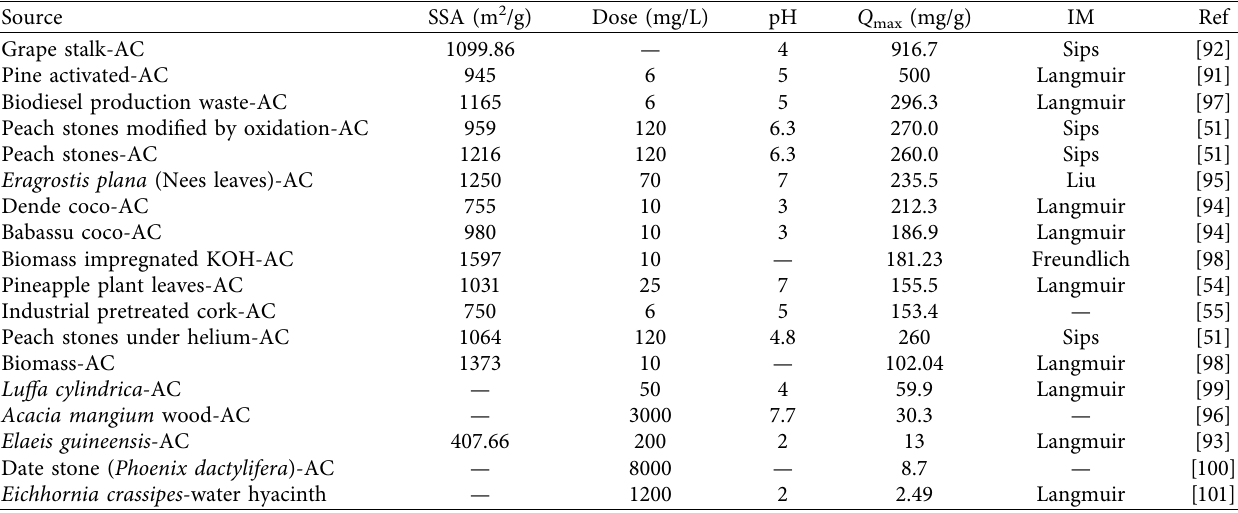
Table 6: Summary of characteristics of agricultural wastes, directly as adsorbents or as precursors for activated carbon, and conditions of the adsorption